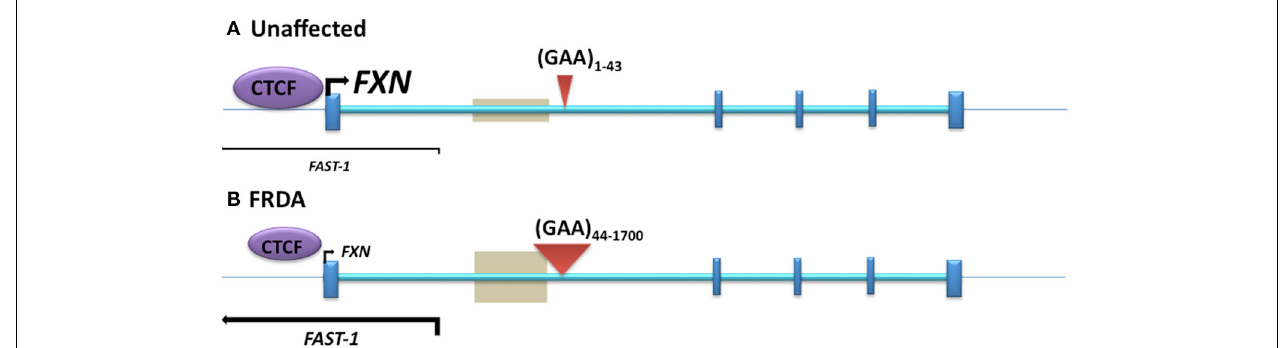
FIGURE 2 | The position of DNA methylation, hydroxymethylation, and CTCF binding sites within the FXN gene. (A) Unaffected: normal-sized GAA repeat (B) FRDA: GAA repeat expansion. Gray boxes represent regions of disease-associated DNA methylation and